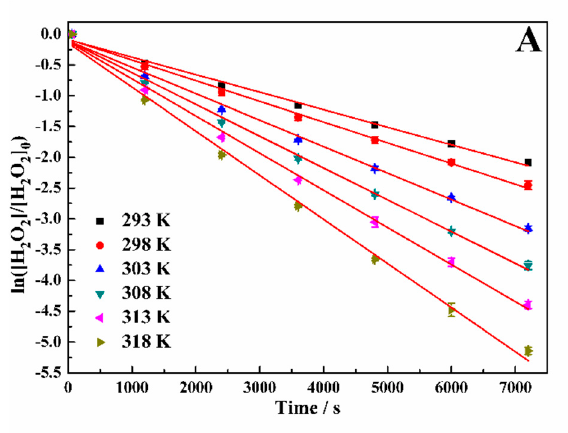
Table 2. The key parameters of the fitted curves with different SA/V values.